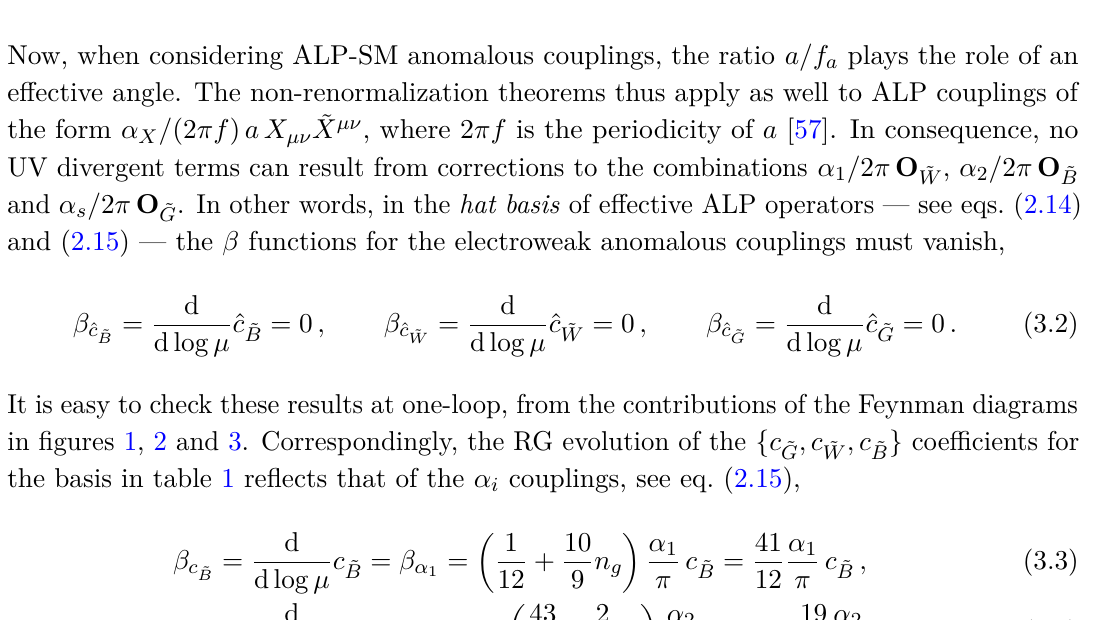
Figure 2 . One-loop diagrams which renormalize the effective a W last diagram stands for one-loop W and SU(2) holds for the other external gauge